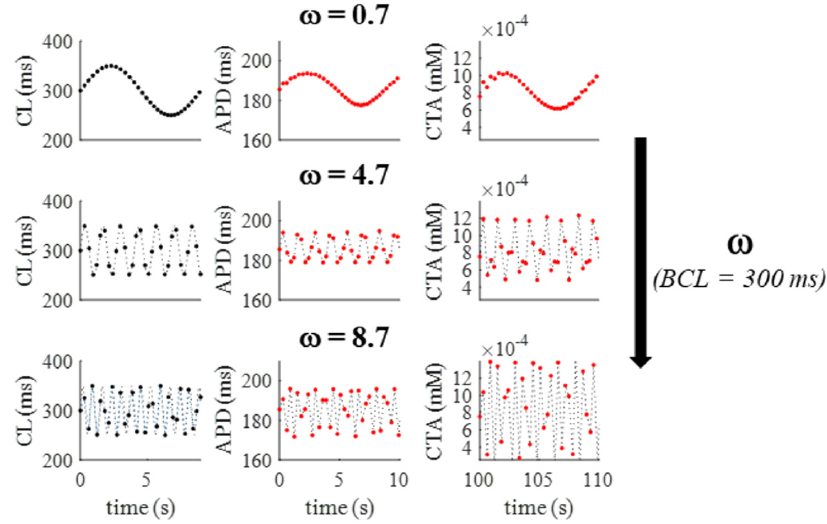
Figure 3. Dependence of APD and CTA oscillations from ω . A: When the OR model was paced according to Equation (1) at a high pacing rate (BCL = 300 ms), the amplitude of APD and CTA oscillations increased with ω (black arrow, values reported in figure).